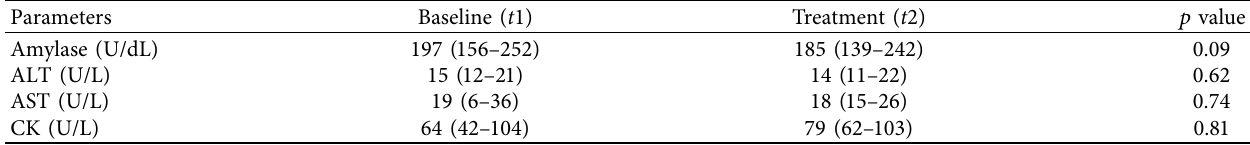
Table 4: Biochemical safety data before and after propolis